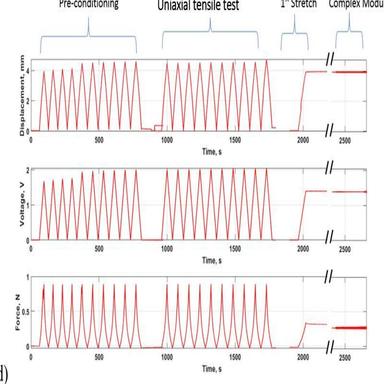
Experimental setup for the complex modulus measurement. (a) I, testing apparatus; II, video extensometer. (b) Scheme of the fixation of the aortic layer to the specimen holder by glue (black in the drawing). (c) Detail of the testing apparatus: 1, laser sport produced from the laser doppler vibrometer used for displacement measurement; 2, aortic strip; 3, piezoelectric dynamic load sensor; 4, static load sensor. (d) Measurement process: pre-conditioning, uniaxial tensile test, stretch, complex modulus test